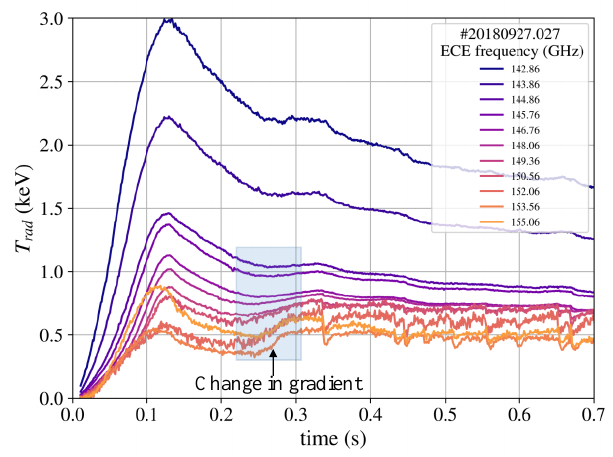
Figure 2: Time traces of ECE channels measuring plasma core to edge (142.86-155.06 GHz) region are shown for #20180927.027. At the start of the plasma discharge around 0.27 s, the temperature gradient changes (the increasing T rad at HFS channels) leading to development of an edge pedestal which is broken by an ELM-like crash at approxi- mately 0.34 s.